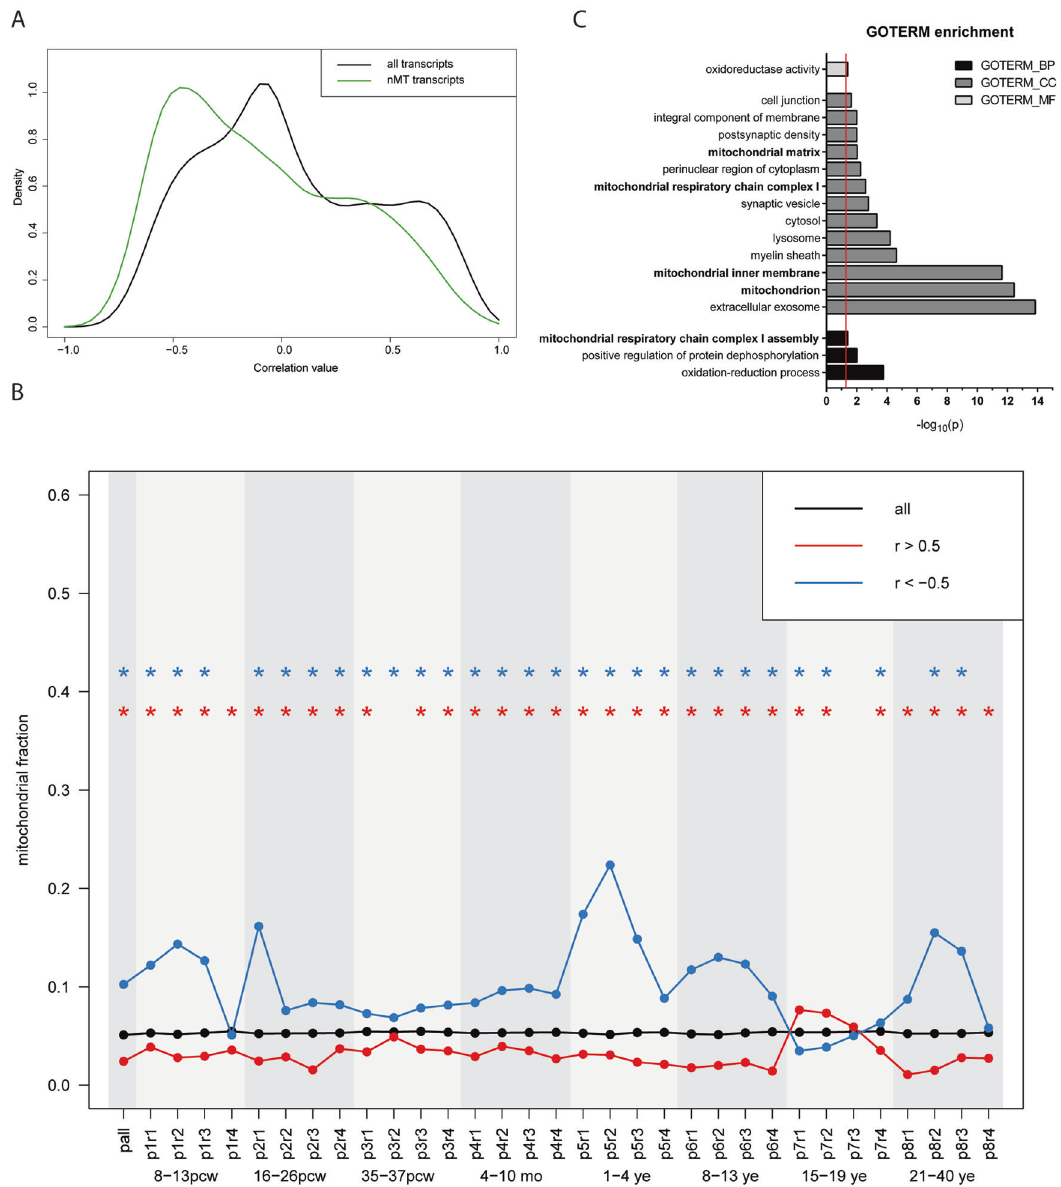
Fig. 2 Spatiotemporal analysis of the correlation between nMT transcripts and BRD1 expression. A Expression of nMT transcripts (green) is negatively correlated with BRD1 expression in the developing human brain compared to the overall gene expression (black). P -value as determined by Mann – Whitney U test. B The fraction of nMT transcripts among all transcripts (black) and among positively (red) and negatively (blue) correlated transcripts is shown for all time points and regions combined (pall) and for each interval (p1r1-p8r4). P -value as determined using Chi-square test or Fisher ’ s Exact test (depending on sample size), where the blue and red asterisks (*) denote p < 0.05 after correction for multiple testing by the Bonferroni method. Temporal intervals (P) were grouped as follows: P1 included pcw 8 – 13 ( fi rst trimester), P2 included 16 – 26 pcw (second trimester), P3 included 35 – 37 pcw (third trimester), P4 included 4 – 10 months, P5 included 1 – 4 years, P6 included 8 – 13 years, P7 included 15 – 19 years, and P8 included 21 – 40 years. Brain regions (R) were grouped as follows: R1 included the posterior inferior parietal cortex, primary auditory cortex, primary visual cortex, superior temporal cortex, and inferior temporal cortex; R2 included the primary somatosensory cortex, primary motor cortex, orbital prefrontal cortex, dorsolateral prefrontal cortex, medial prefrontal cortex, and ventrolateral prefrontal cortex; R3 included the striatum, hippocampus, and amygdala; and R4 included the mediodorsal nucleus of the thalamus, and cerebella cortex. Abbreviations: post-conception week (pcw); months (mo); years (ye). C GOTERM enrichment analyses. Negatively correlated transcripts were enriched for mitochondria-related GOTERMs (highlighted in bold). P -value is presented as EASE Score, a modi fi ed Fisher Exact P -value and corrected for multiple testing by the Bonferroni method. Red line at p adjusted = 0.05.